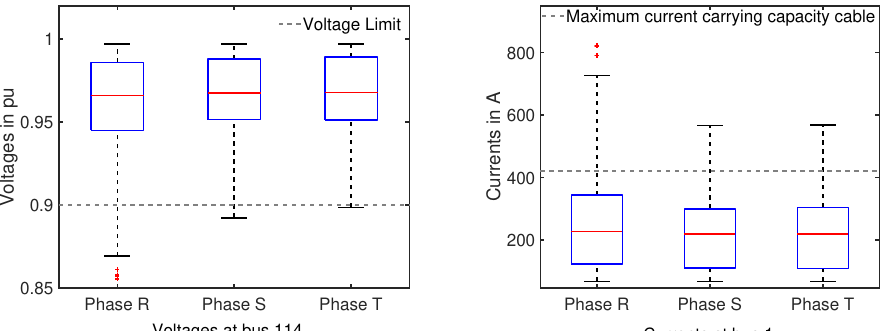
Figure 7. Phase voltages at bus 114 and phase currents at bus 1 for UC with massed connection at R and EVs distributed at the end of the